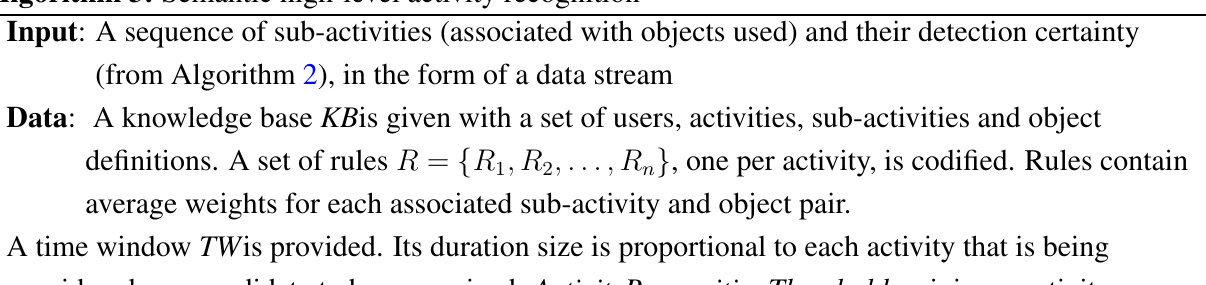
Algorithm 3: Semantic high-level activity